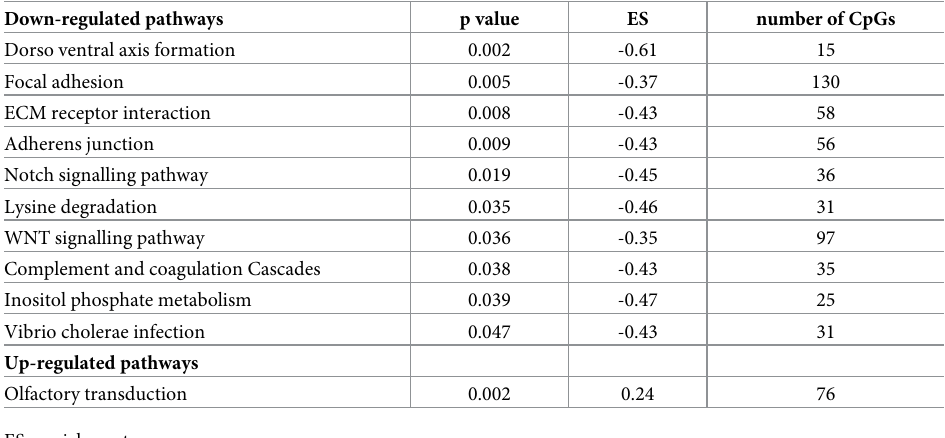
Table 2. Up- and down-regulated pathways from RIDMs in nasal epithelial cells of asthmatics vs. controls. Down-regulated pathways p